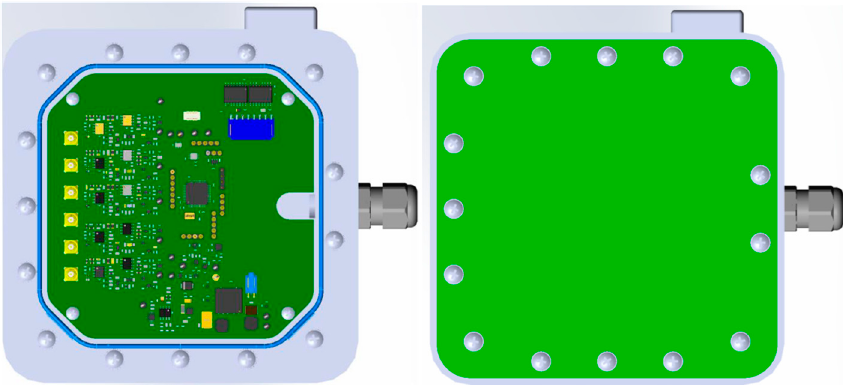
Figure 5 . Potentiometric Sensor AFE mechanical file . Figure 5. Potentiometric Sensor AFE mechanical